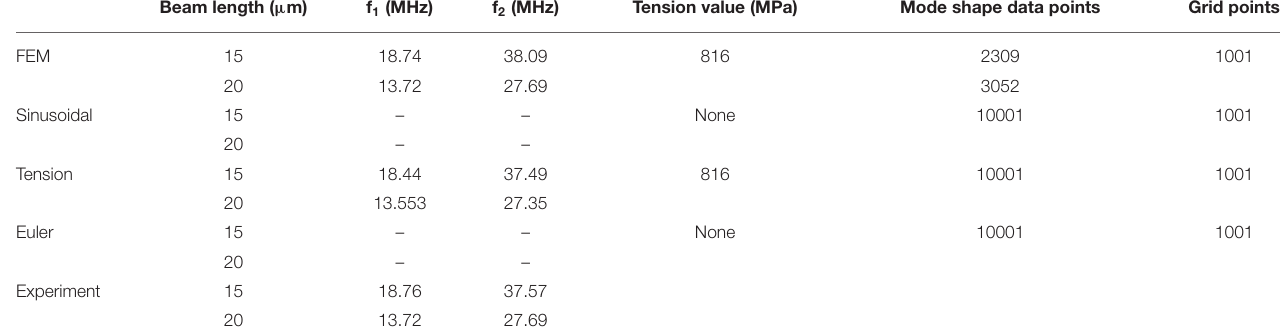
TABLE 1 | Resonance frequencies.